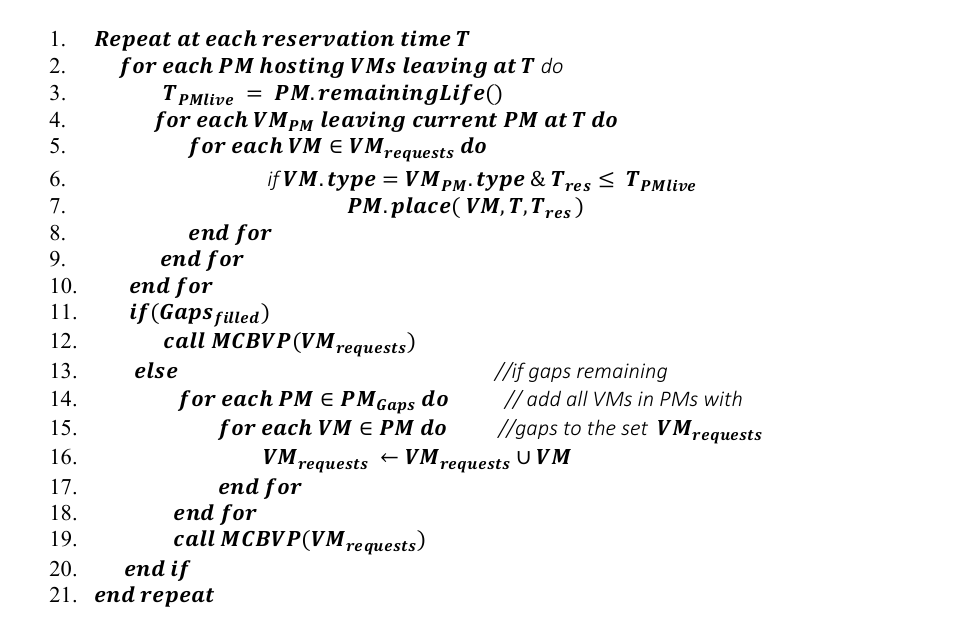
Algorithm 1: Bulk-Bin-Packing based Migration Management